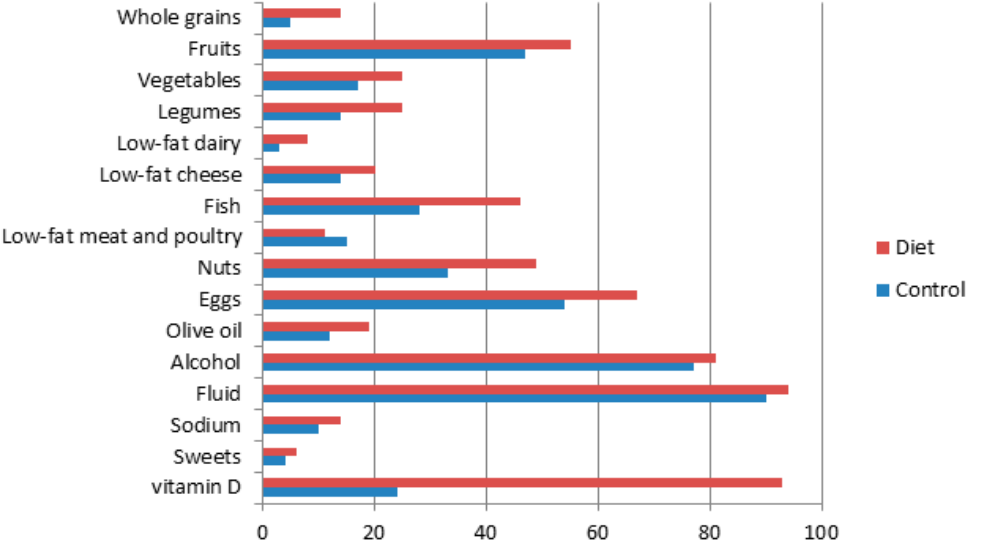
Figure 3. Percentage of participants in the control and NU-AGE diet group meeting the NU-AGE guidelines after one-year NU-AGE dietary intervention.